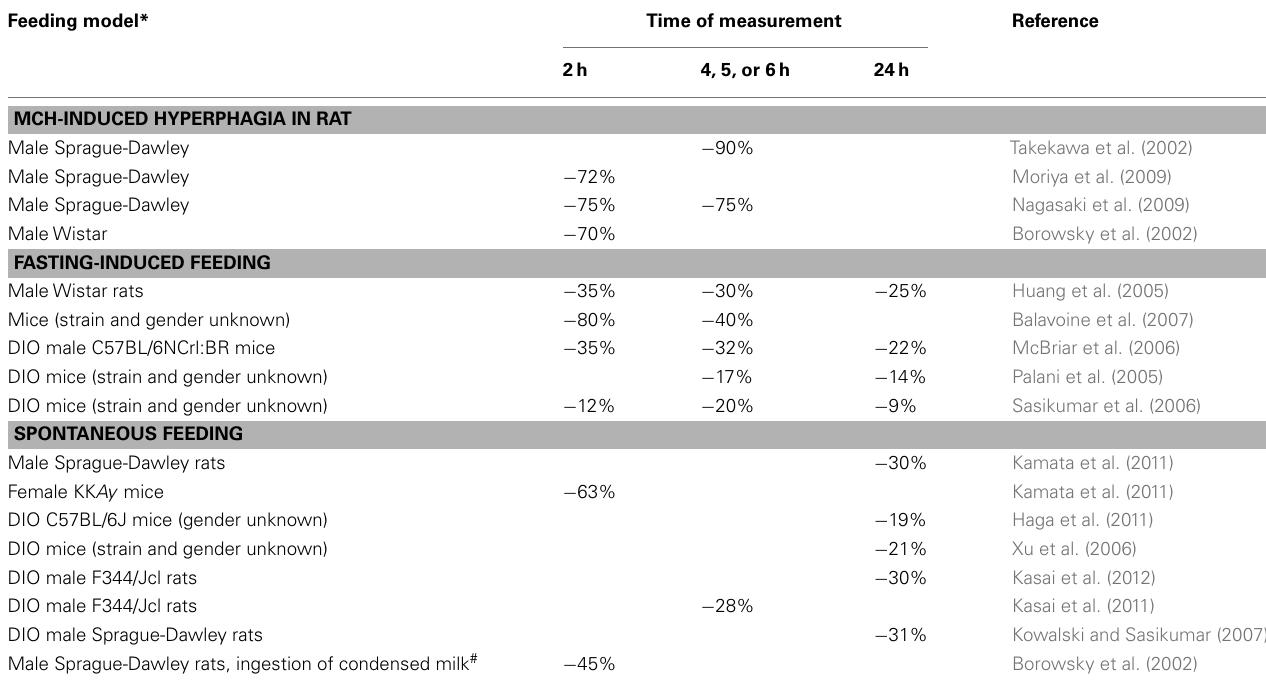
Table 2 |Acute effects of non-peptide MCH1R antagonists on food